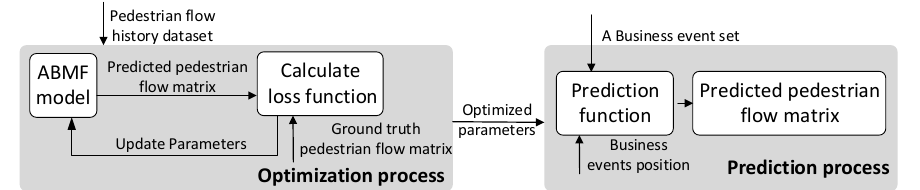
Figure 3. Framework of pedestrian flow prediction with business